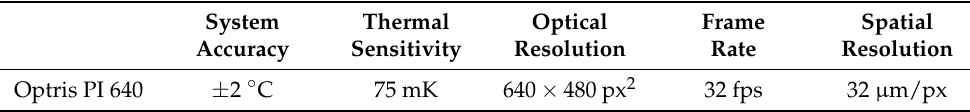
Table 2. Specifications of the Optris PI 640 infrared camera.